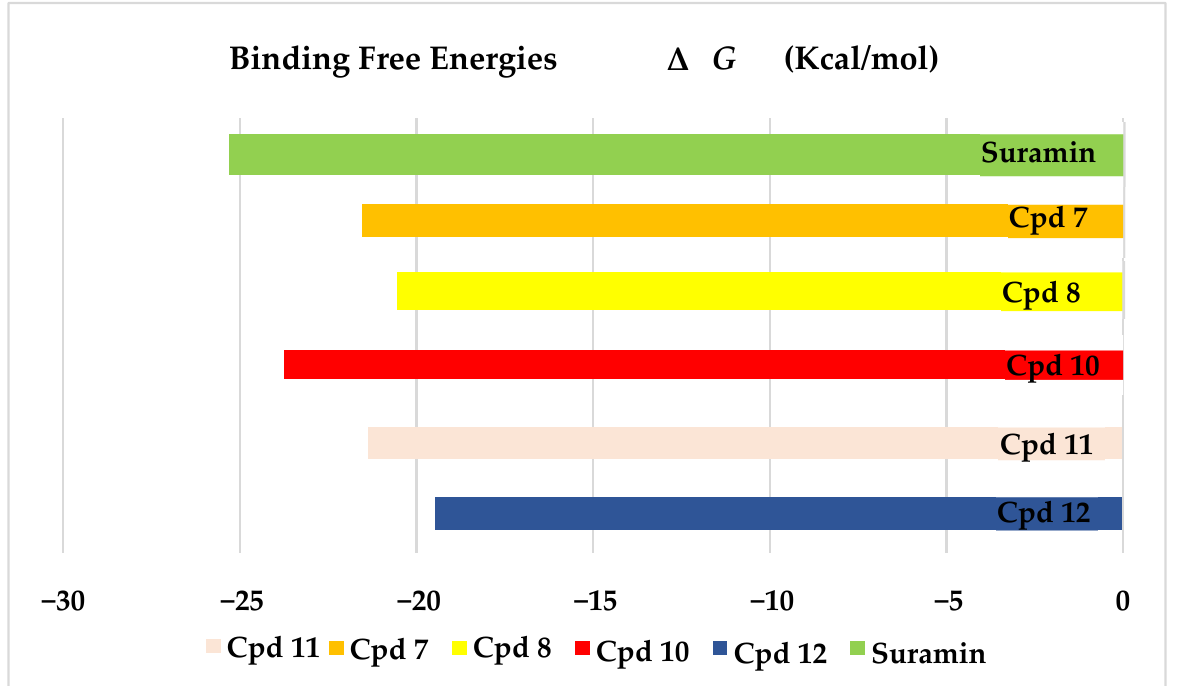
Figure 4. Binding free energy score of the most active isolated compounds and suramin with T. brucei PFK enzyme (PDB ID:3F5M).